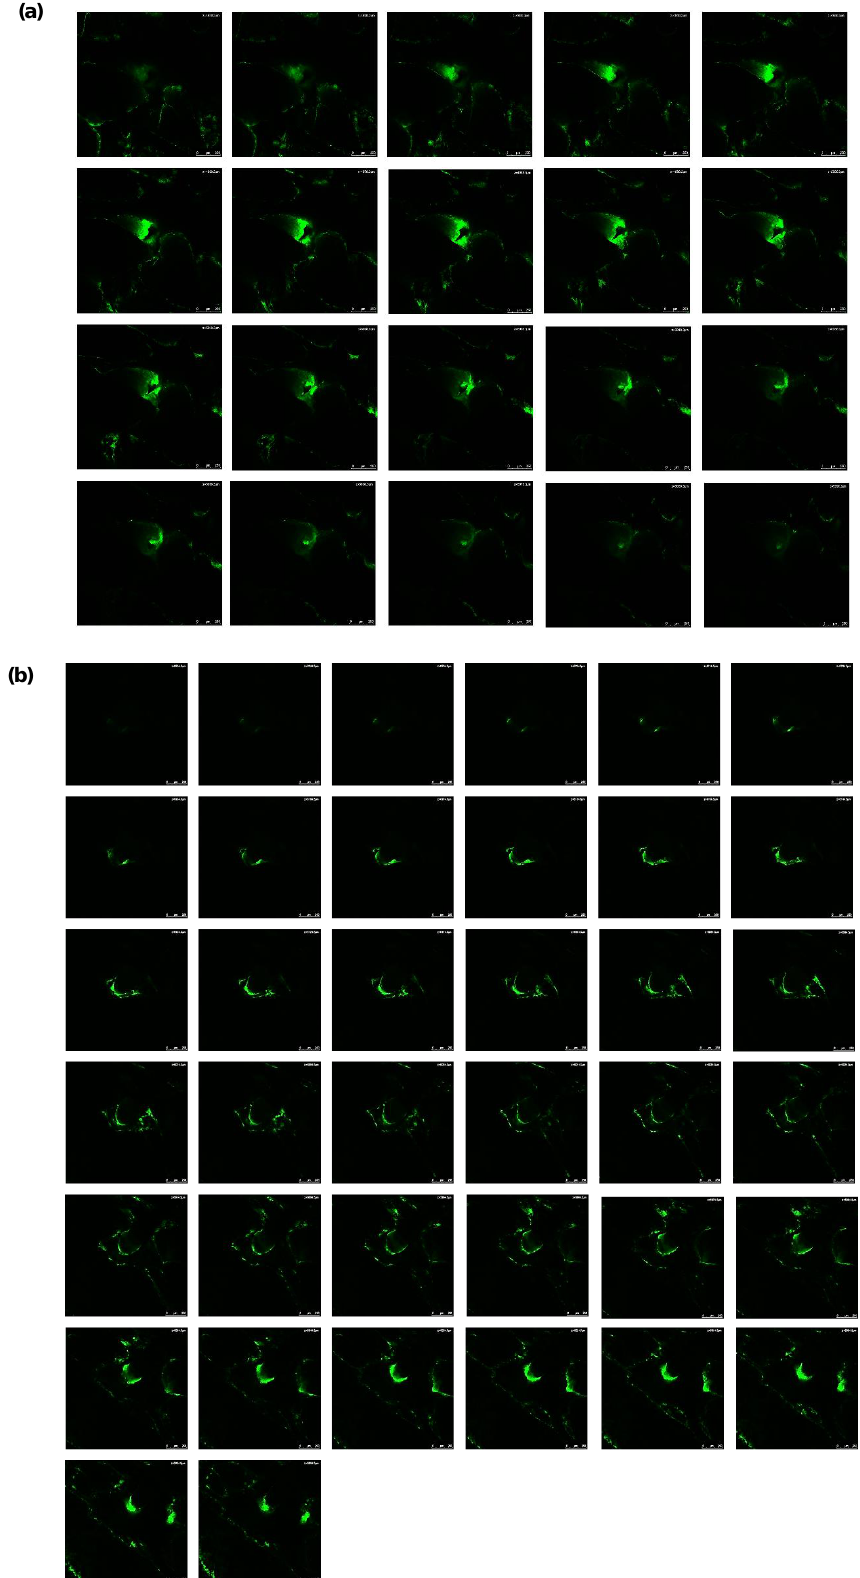
Figure 3. Confocal microscopy z-stack of microchannels created by Dr. Pen TM Ultima A6 with (a) 0.5 mm needle length applied for 5 s, and (b) 1 mm needle length applied for 10 s, both at 13,000 insertions/min. Scale bar represents 250 µm.